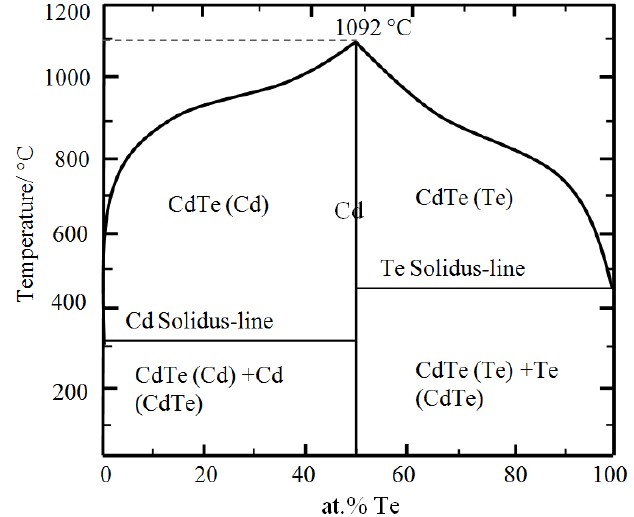
Figure 17. Phase diagram for CdTe showing the effects of temperature and stoichiometry. Re-drawn from